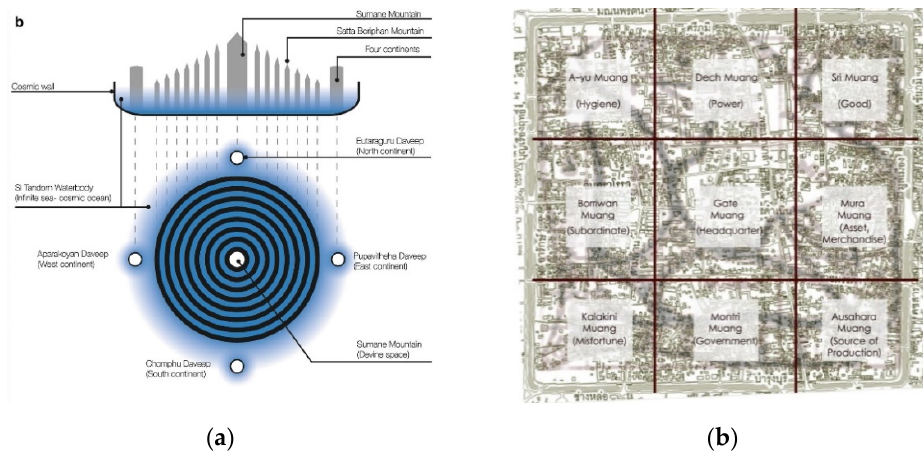
Figure 3. ( a ): Triphum Concept (Srinurak and Mishima 2017, p. 4). ( b ) The simulation of the city map to the belief of “body and soul” of city and the hierarchy of city doors and city’s areas (Author).